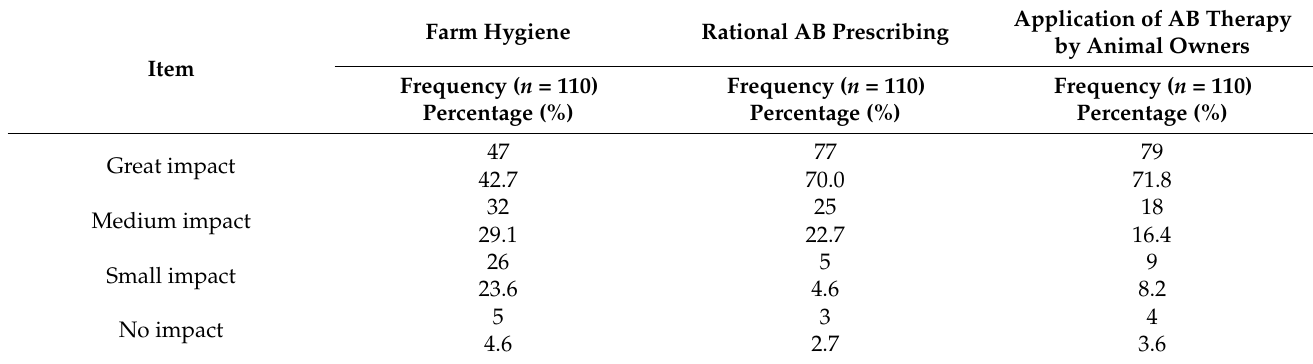
Table 5. The impact of various sectors affecting the development and spread of AMR.